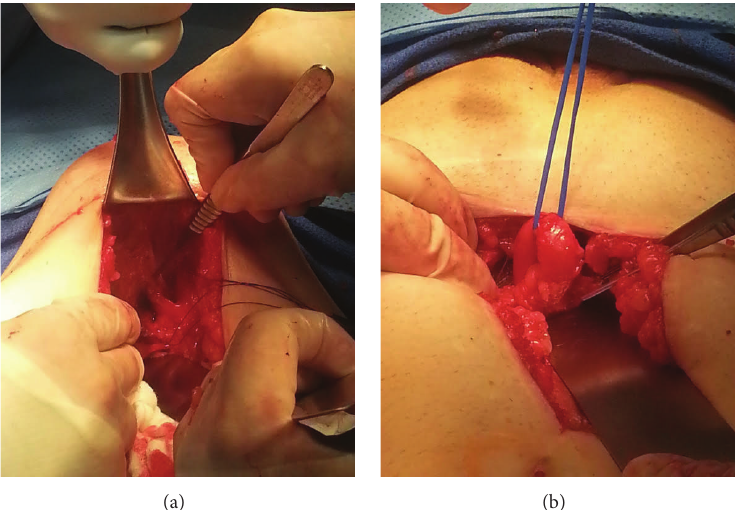
Figure 2: Hernia defect seen within the preperitoneal space (a); vessel loop around the redundant transplant ureter reduced from the hernia